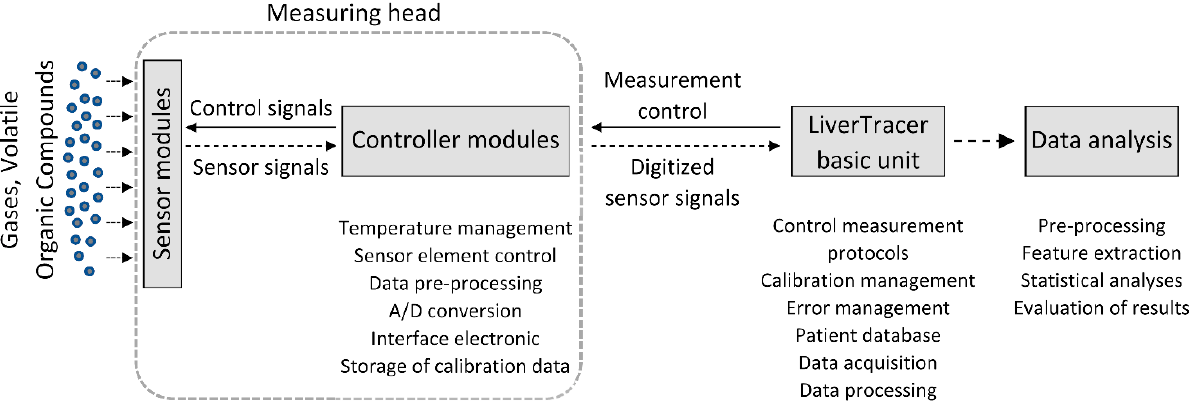
Figure 1. Setup of the electronic nose system